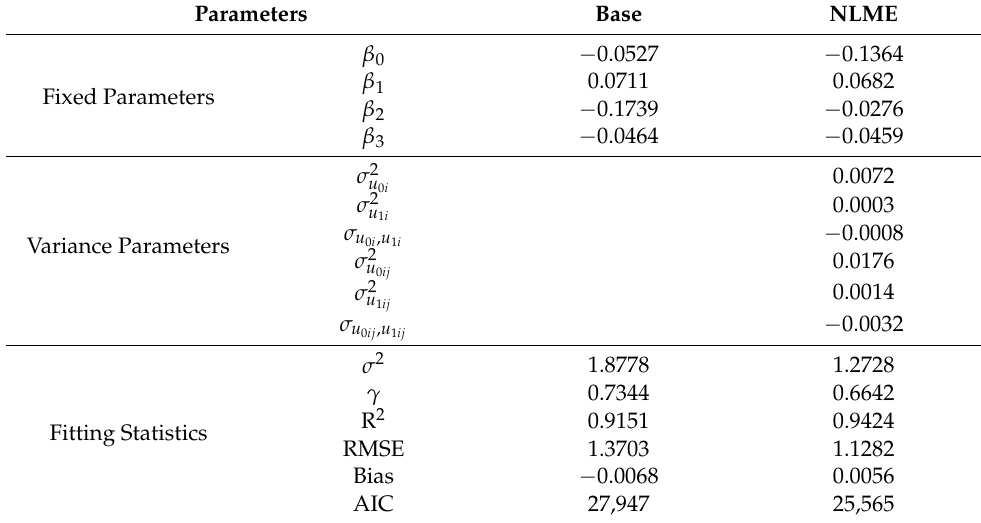
Table 3. Parameter estimates and fitting statistics for the base and NLME model.